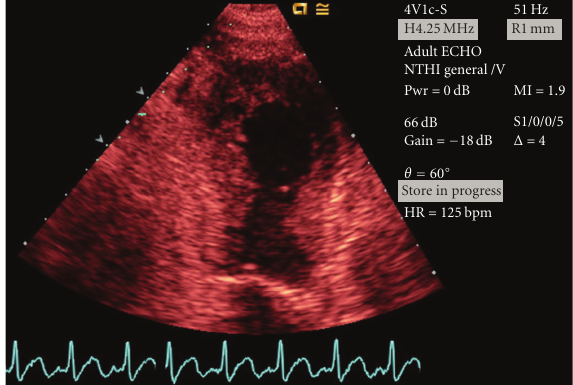
Figure 2: Left ventricular apical akinesia and ballooning visualized during systole on echocardiography.